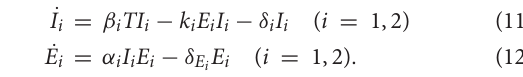
Frontiers in Microbiology |